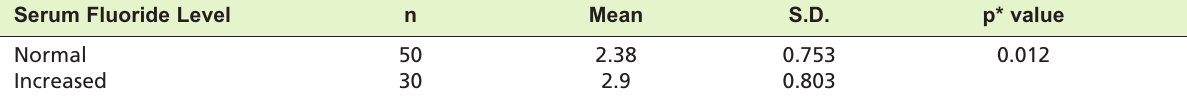
Comparison of Kellgrens and Lawrence grades with serum fluoride levels Table III: Serum Fluoride